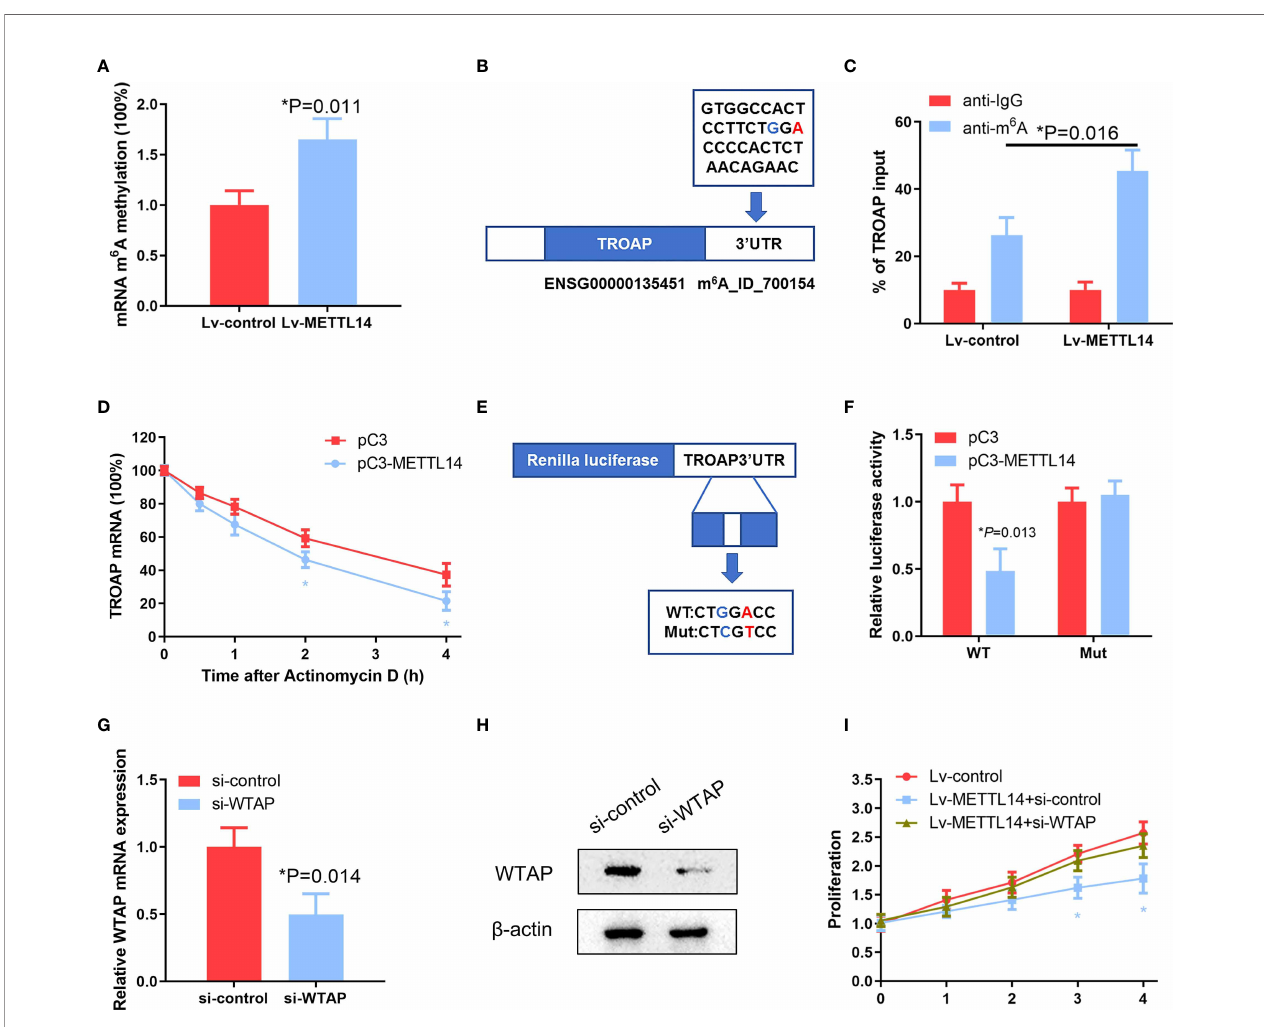
FIGURE 6 | METTL14 destabilize TROAP mRNA through the m 6 A mRNA methylation. (A) Detection of mRNA m 6 A methylation in SKOV-3 cells transfected with the METTL14 expression plasmid (* P = 0.011). (B) Predicted m 6 A RNA methylation site using the m 6 AVar prediction website. (C) Enrichment of m 6 A-modi fi ed TROAP in METTL14-overexpressing SKOV-3 cells. Input percentage is shown (* P = 0.016). (D) Changes in the m 6 A-modi fi ed TROAP levels with METTL14 overexpression. SKOV-3 cells were transfected with pC3 or pC3-METTL14 plasmids for 36 h. The stabilization of mRNA was initiated by treatment with an RNA polymerase II inhibitor [actinomycin D (5 m g/ml)]. Cells were collected at the indicated timepoints. At 0 h, the expression rates were normalized to that of GAPDH mRNA. Data are shown as the average of three or more different studies (*P < 0.05). (E) Representative cloning scheme for the wild-type and mutant TROAP 3 ′ UTR renilla luciferase vectors. (F) Co-transfection of these luciferase constructs with pC3 or pC3-METTL14 expression vectors into SKOV-3 cells. Data are shown as the average of three or more independent experiments (* P = 0.013). (G, H) Analyses of WTAP expression levels by qRT-PCR and western blot in SKOV-3 cells transfected with si-control or si-WTAP (* P = 0.014). (I) Cell proliferation analysis of stable METTL14-overexpressing SKOV-3 cells transfected with si-control or si-WTAP (*P < 0.05). Graphical data represented as the mean ±